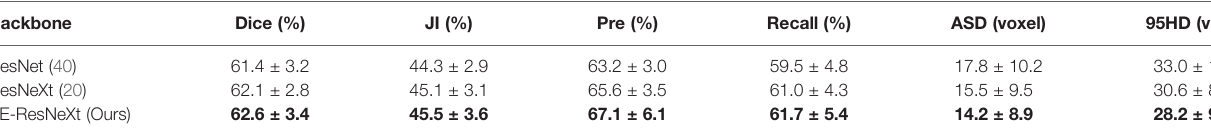
Mean ± SD, with best results highlighted in